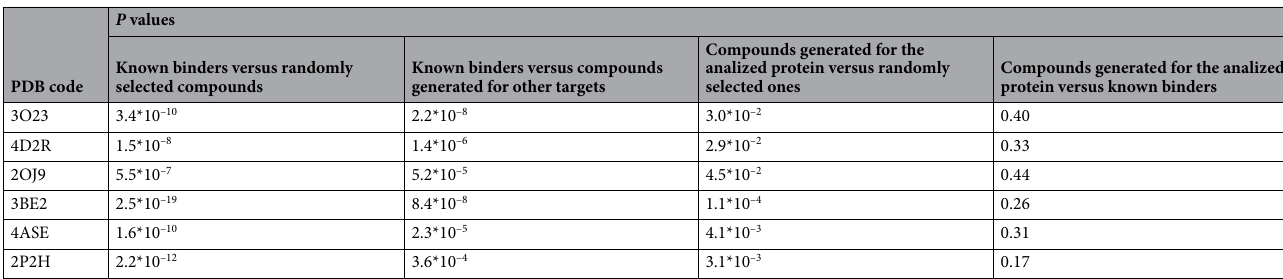
Table 4. P values of the Mann–Whitney test for all molecule sets used in the analysis.